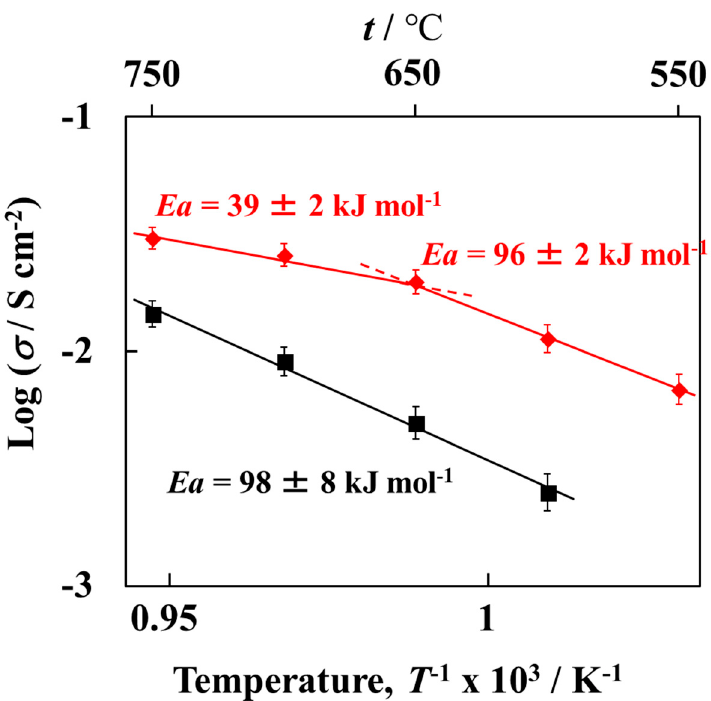
Figure 5. Arrhenius plots for the apparent electrode interface conductivity of the Ni/YSZ|YSZ|Ni/YSZ ( ■ ) and Ni 0.75 Co 0.25 /YSZ|YSZ|Ni 0.75 Co 0.25 /YSZ ( ◆ ) cells in CH 4 .